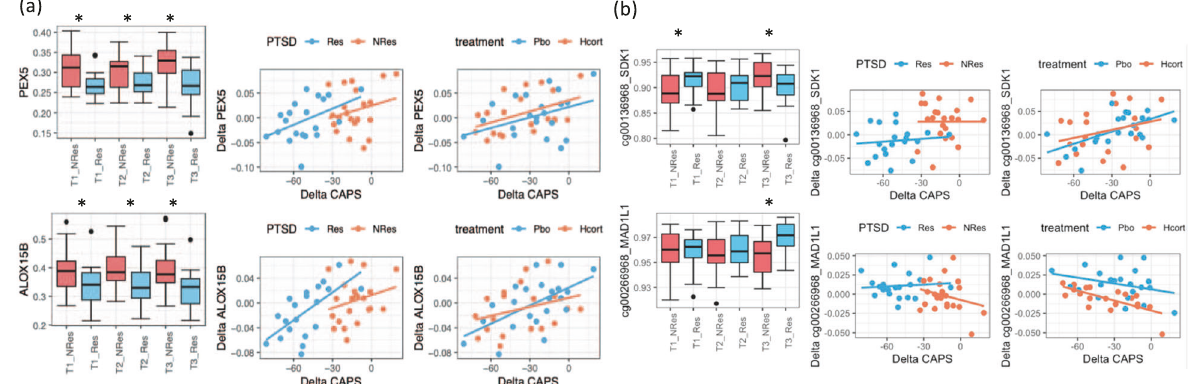
Fig. 1 Putative markers predict treatment outcomes. a The most signi fi cant markers. (Left) Time-course difference between PTSD responders ( N = 20) and nonresponders ( N = 22). (Middle) Relationship of methylation between pretreatment (T1) and PTSD-symptom severity at 3-month post treatment (T3) grouped by responders and nonresponders. (Right) Relationship of methylation and PTSD-symptom severity changes grouped by treatment. b The reported markers showing the T1 and T2 response or treatment difference (* Statistical signi fi cance was set at p < 0.05).